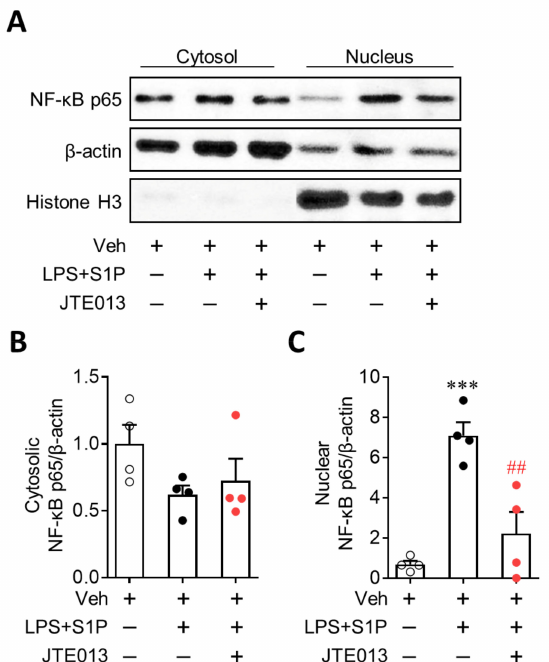
Figure 6. S1P 2 regulates NF- κ B activation in LPS-primed BMDMs followed by S1P exposure. Cells were pretreated with JTE013 (10 µ M) for 30 min. Cells were then primed with LPS (500 ng/mL) for 4 h and exposed to S1P (1 µ M) for 1 h. Effects of JTE013 on NF- κ B translocation from the cytosol to the nucleus were analyzed by Western blot. Representative blots of cytosolic and nuclear NF- κ B p65 ( A ) and quantification ( B , cytosolic NF- κ B p65; C , nuclear NF- κ B p65) are shown. n = 4 per group. *** p < 0.001 versus control BMDMs (Veh). ## p < 0.01 versus LPS/S1P-treated BMDMs (LPS +